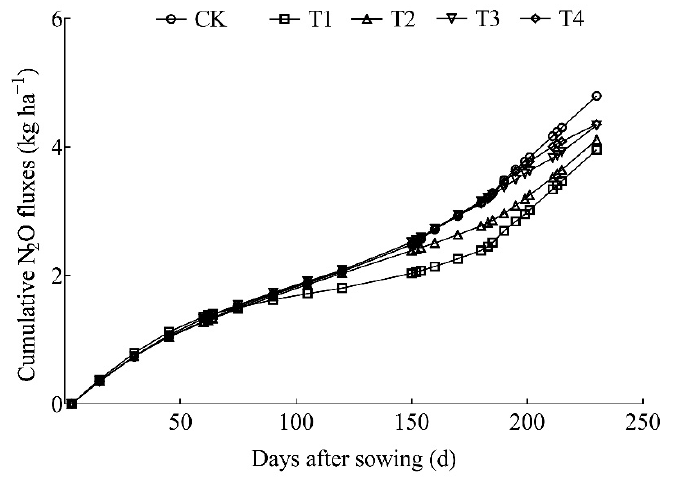
Figure 5. Cumulative soil N 2 O emissions (kg ha − 1 ) under different irrigation treatments during a winter wheat growing season.